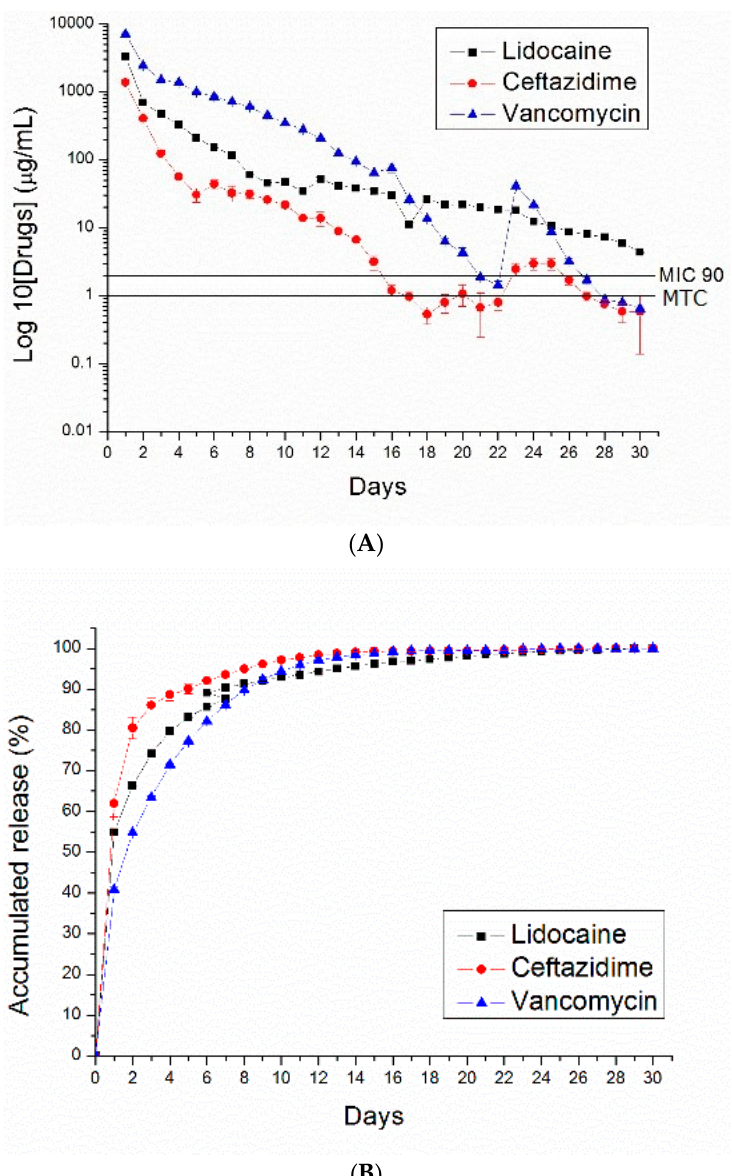
Figure 11. PLGA (75:25)-( A ) daily and ( B ) accumulated release curves of pharmaceuticals from 200 mg PLGA nano/microparticle-loaded buffered solution.